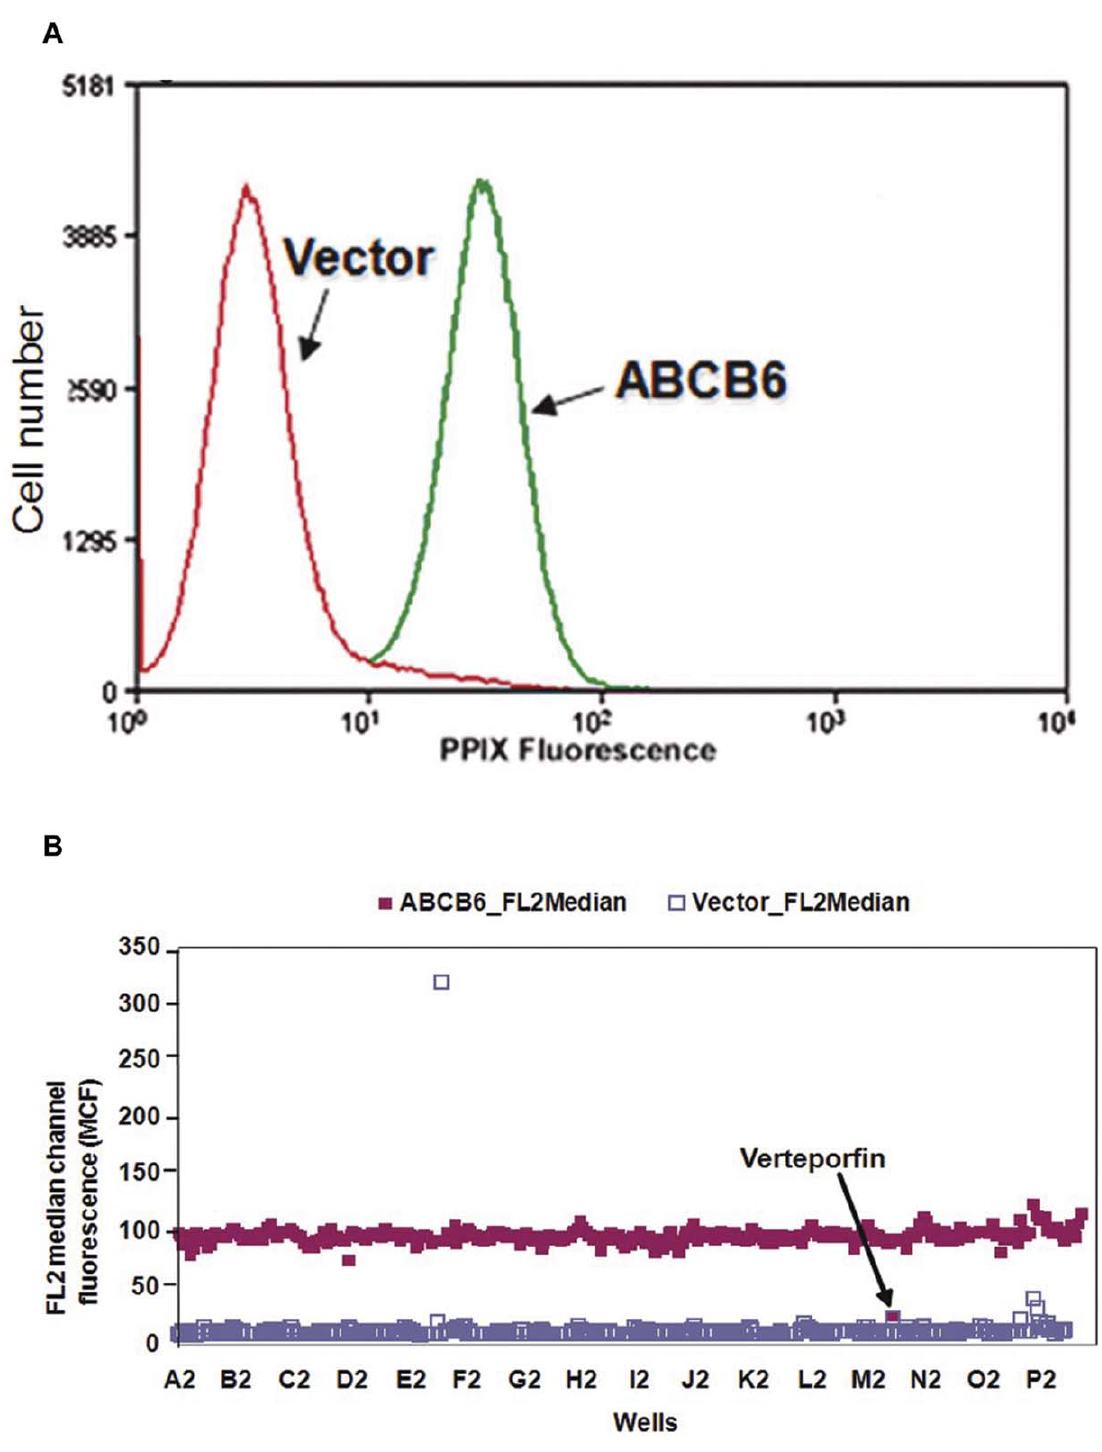
Figure 1. Assay development at University of New Mexico Center for Molecular Discovery (UNMCMD). (a) Human erythroid leukemia cells (K562) expressing ABCB6 accumulate more porphyrins compared to the vector control cells as measured by flow cytometry. (b) Flow cytometric HTS of Prestwick Chemical Library (PCL). The figure depicts data from a representative PCL plate demonstrating decrease in FL2 fluorescence (representing PPIX fluorescence) mediated by verteporfin. The Y-axis displays the amount of fluorescence (FL2 log channel representing PPIX fluorescence). The X-axis displays each well. In the assays time bins were automatically drawn around the clusters by using IDLQuery software programs, each cluster corresponds to one well. The red square represents the PPIX fluorescence in untreated ABCB6 overexpressing cells while the white square represents the PPIX fluorescence in vector control cells. The arrow highlights the decrease in PPIX fluorescence of ABCB6 expressing cells in the presence of verteporfin.